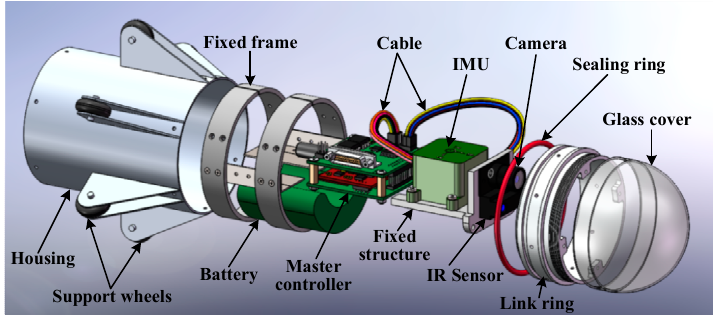
Figure 11. Exploded views of the sensor head.